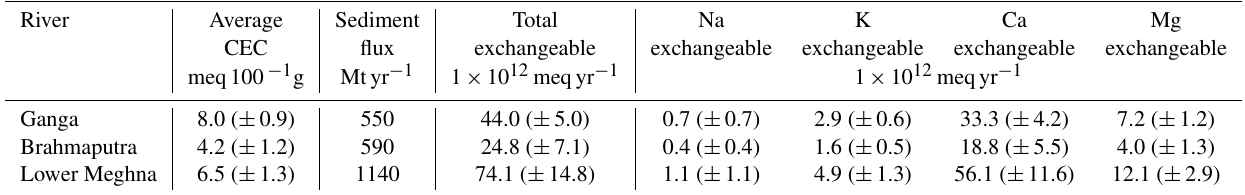
Table 2. Sediment fluxes (RSP, 1996), average CEC of the sediments and exchangeable flux of major cations bound to the river sediments. River